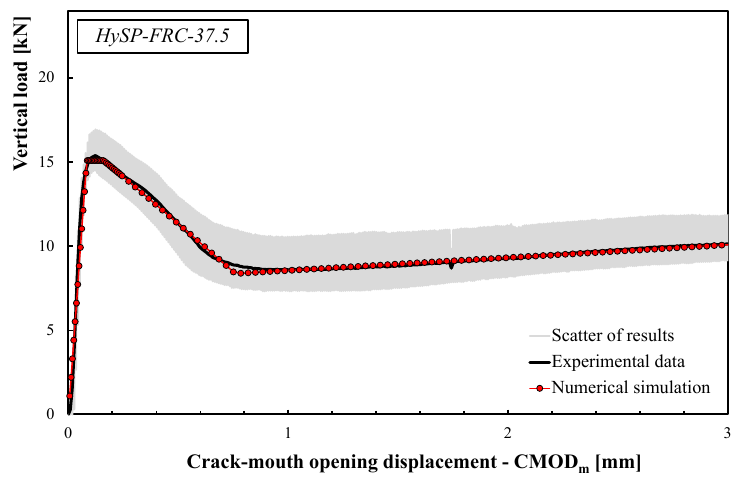
Figure 9. Experimental and numerical load–CMOD curves for the HySP-FRC-55-20 mixture.